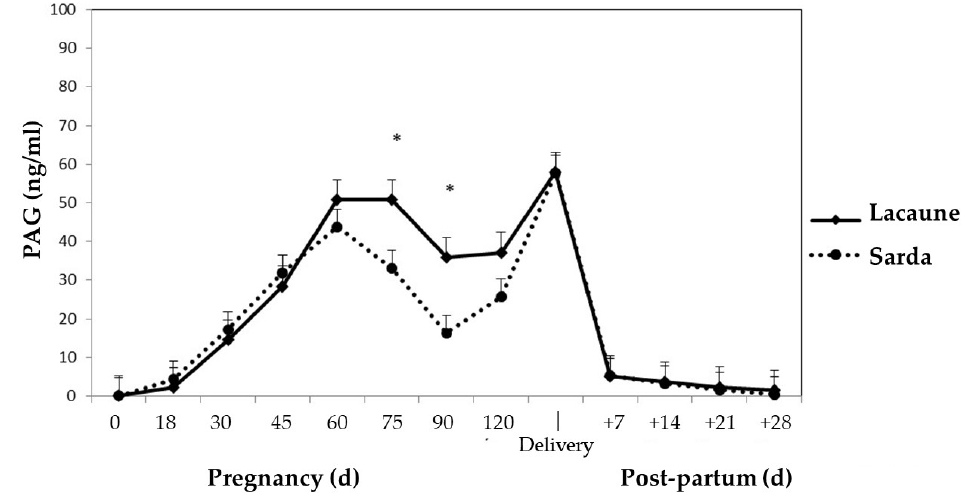
Figure 3. Pregnancy-associated glycoprotein (PAG) plasma profile in Lacaune and Sarda ewes during pregnancy and the post-partum period. * p < 0.001. Adapted from De Carolis et al. [89].